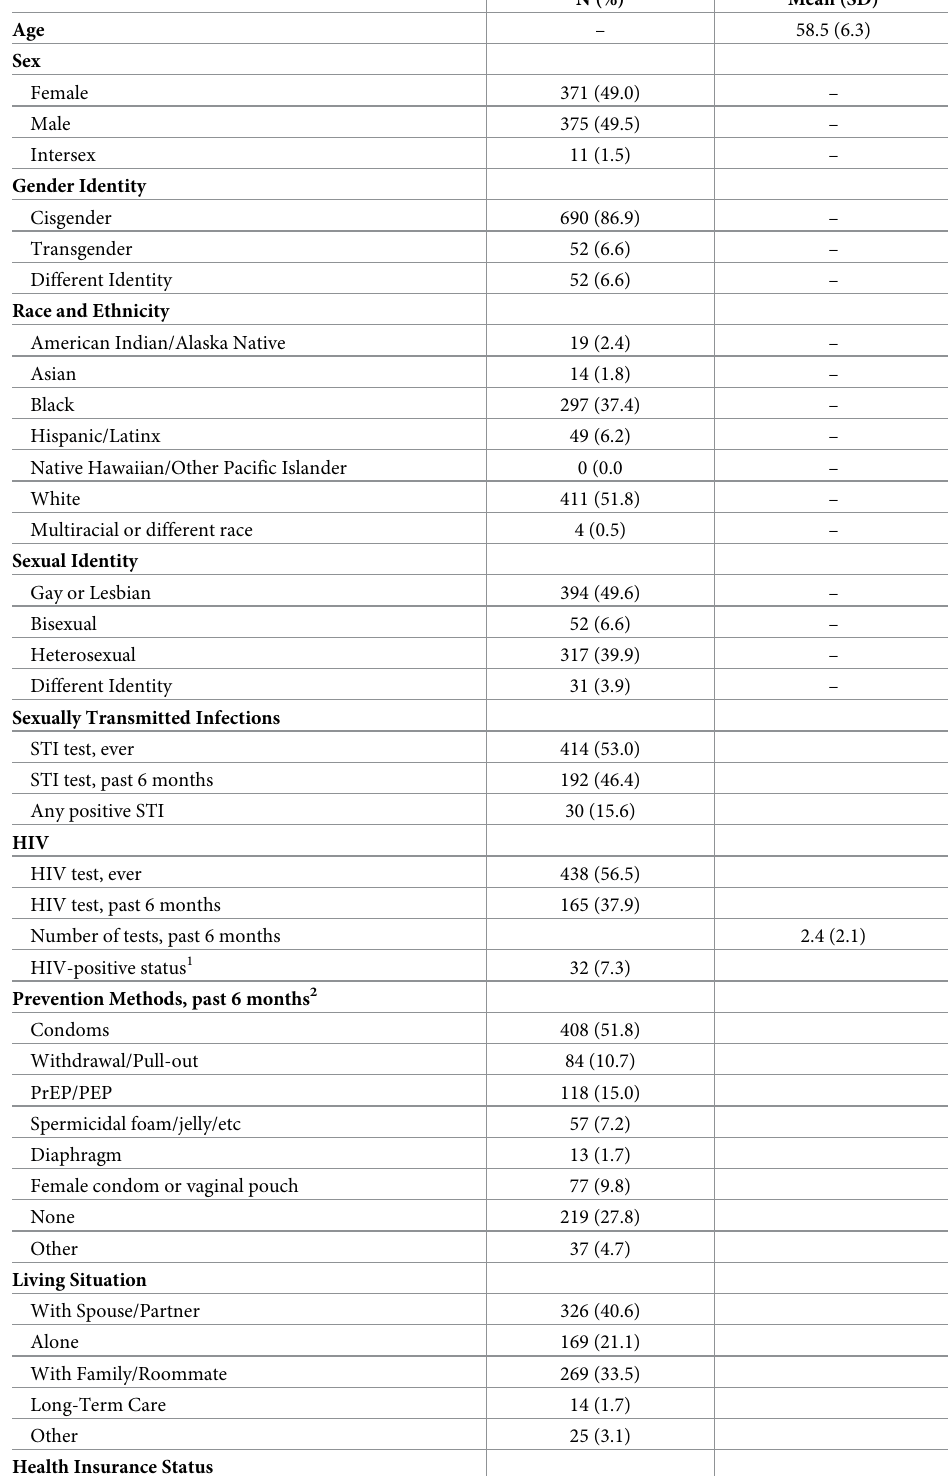
Table 1. Demographic attributes of the Columbus Healthy Aging Project, Columbus, OH (N =